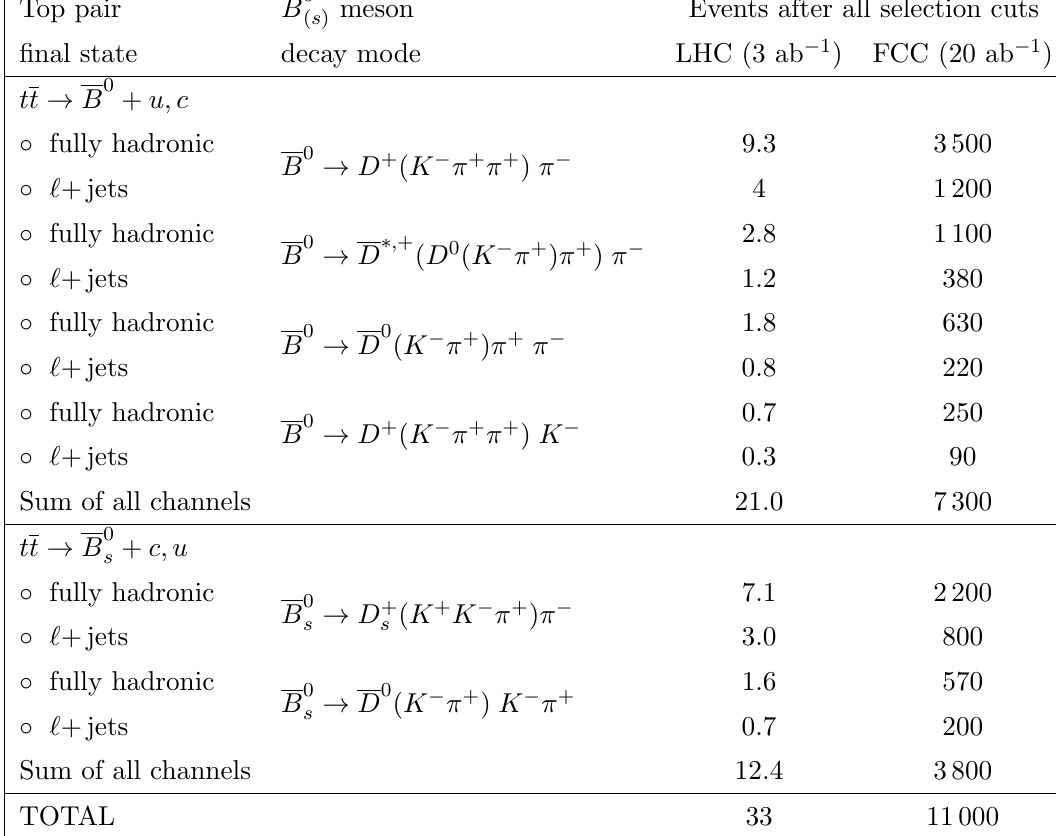
Table 9 . Expected number of t ! B 0 + jet events in selected tt (cid:12)nal-states (fully hadronic, and ( s ) ‘ + jets) with B 0 -meson decays into a D -meson plus 1 or 2 light mesons, after estimating branching ( s ) ratios and detector acceptance losses, in pp collisions at the LHC and